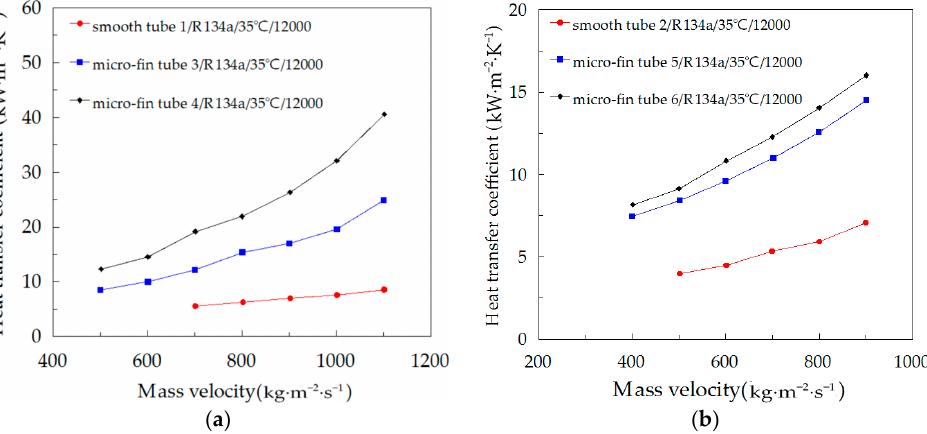
Figure 10. Influences of structural parameters of the test tube on the heat transfer coefficient inside ( a ) tubes 1, 3 and 4 and ( b ) 2, 5 and 6 for R134a.